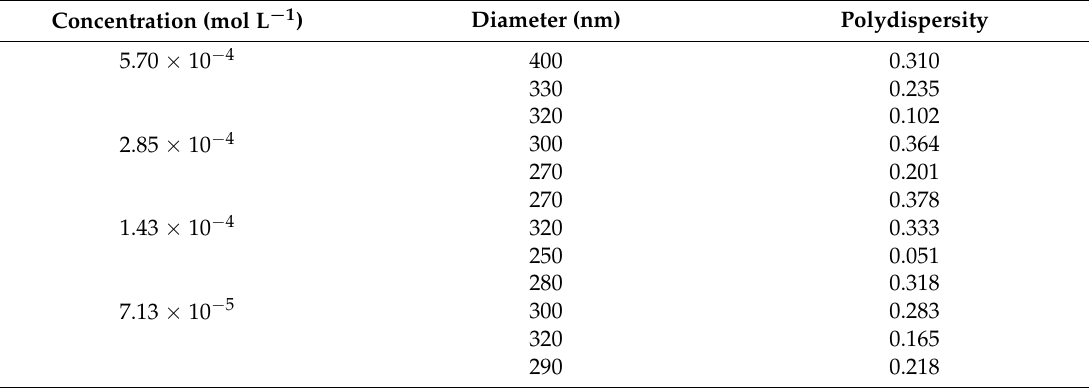
Table 1. Particle size of 3 in water measured by dynamic light scattering.